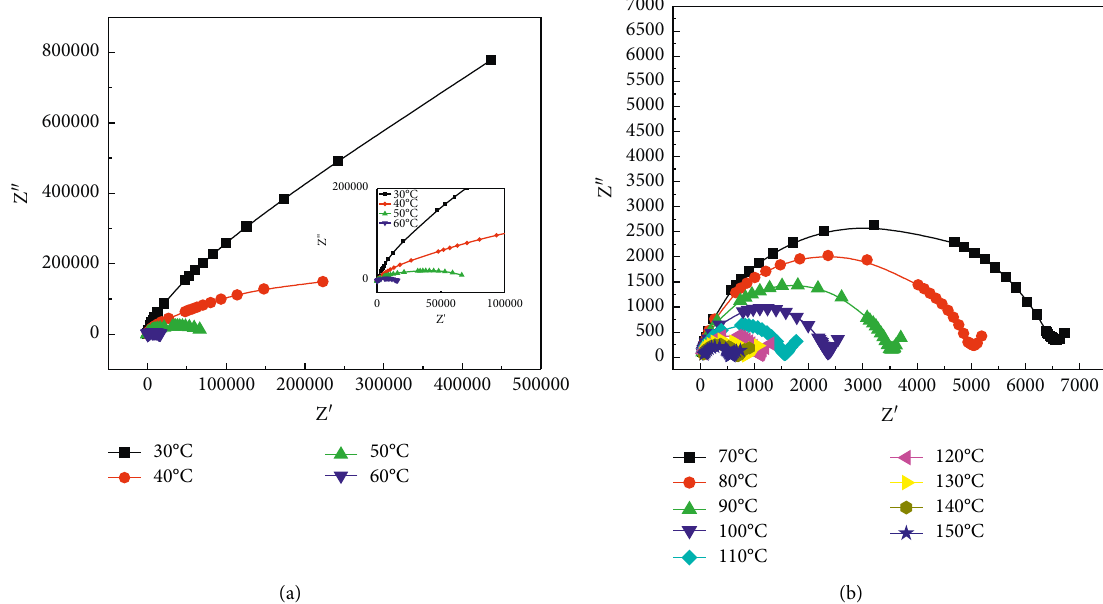
Figure 8: Complex plane plots (Z from 70 to 150 ° C.